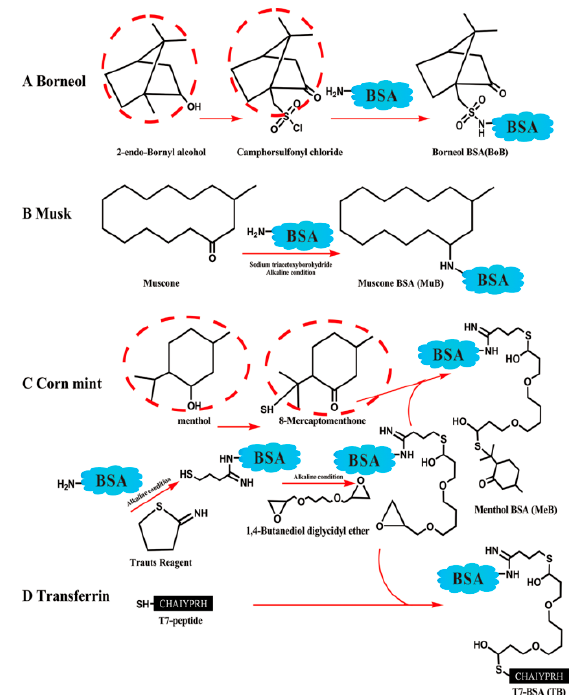
Figure 4. Schemes of modified albumin including borneol BSA ( A ), muscone BSA ( B ), menthol BSA ( C ), and T7 BSA ( D ). Reproduced with permission from Liang, J.; Gao, C.; Zhu, Y.; Ling, C.; Wang, Q.; Huang, Y.; Qin, J.; Wang, J.; Lu, W.; Wang, J. Natural Brain Penetration Enhancer-Modified Albumin Nanoparticles for Glioma Targeting Delivery. ACS Appl. Mater. Interfaces 2018